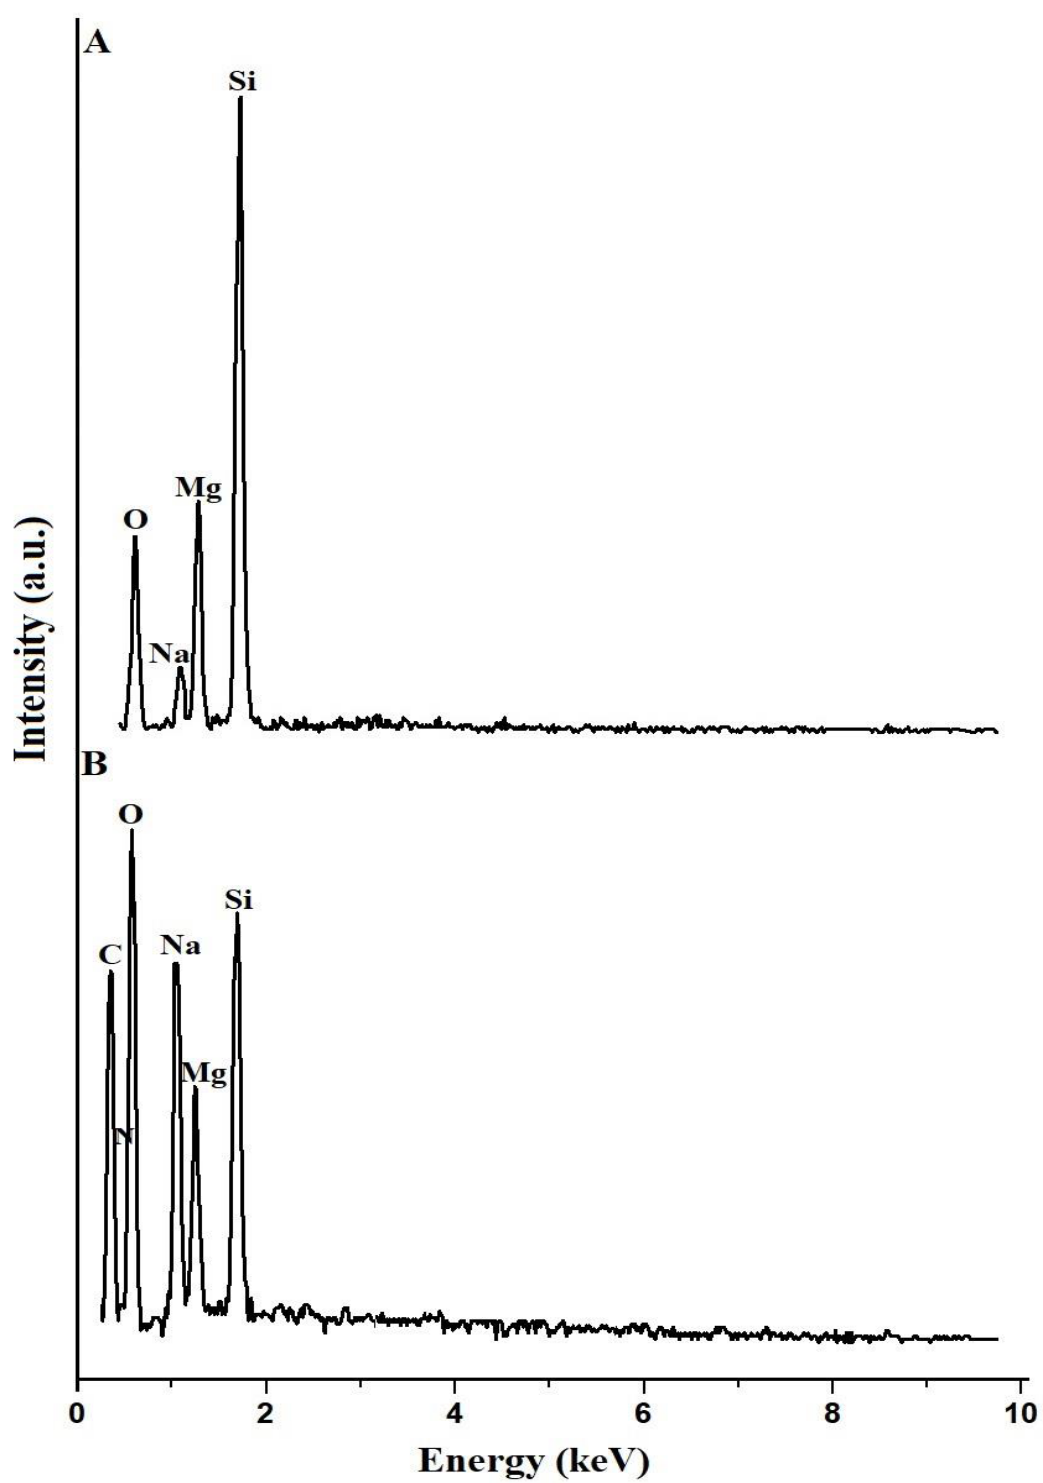
Figure 2. The EDX patterns of the F1 (nanostructures) ( A ) and F1S (nanocomposites) ( B ) samples.